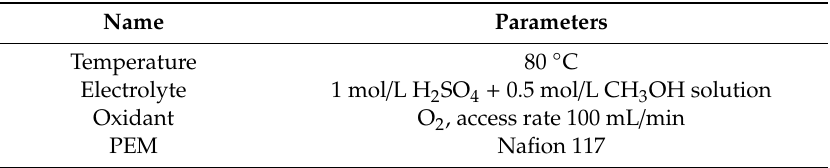
Figure 11. Polarization curves of DMFC with different proton exchange membranes (PEMs).